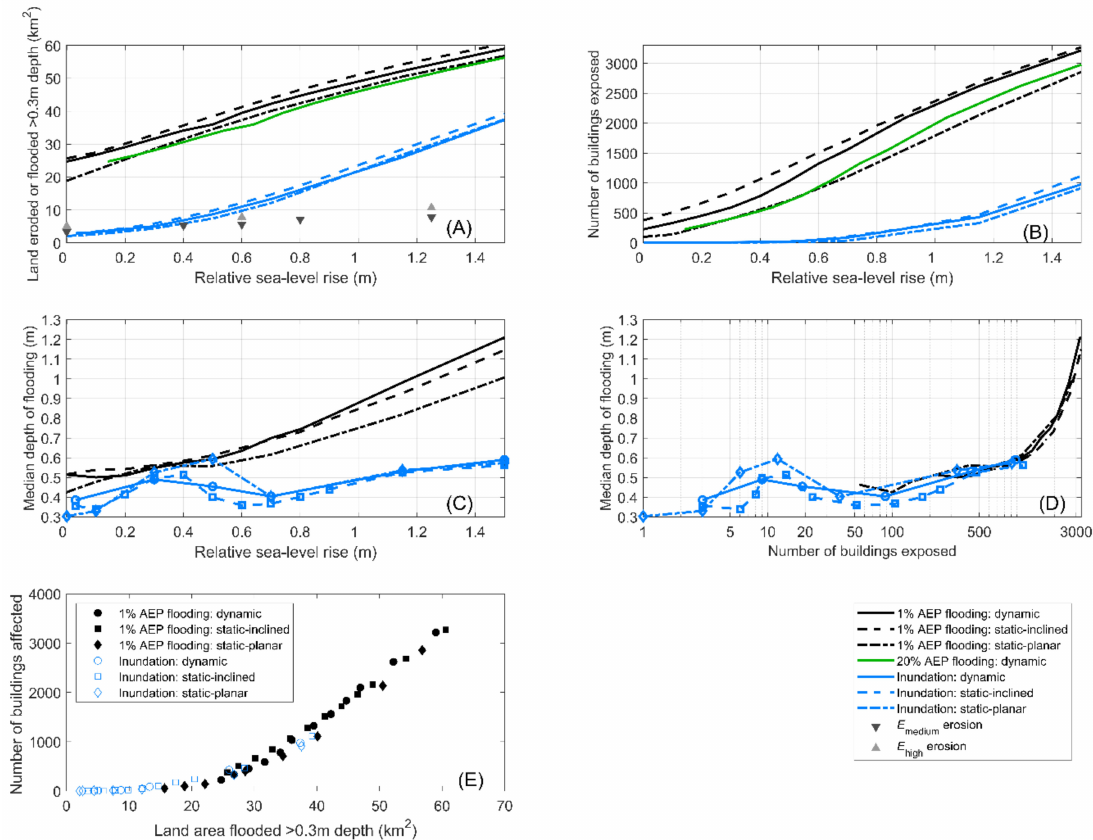
Figure 4. Coastal flooding, permanent inundation and erosion exposure in Tauranga Harbour with relative sea-level rise: ( A ) RSLR versus land area exposed to ≥ 0.3 m coastal flood depth, ( B ) RSLR versus number of buildings exposed to coastal flooding and inundation, ( C ) RSLR versus median depth of coastal flooding, ( D ) number of buildings exposed versus median depth of coastal flooding and ( E ) Relationship between land area and number of buildings